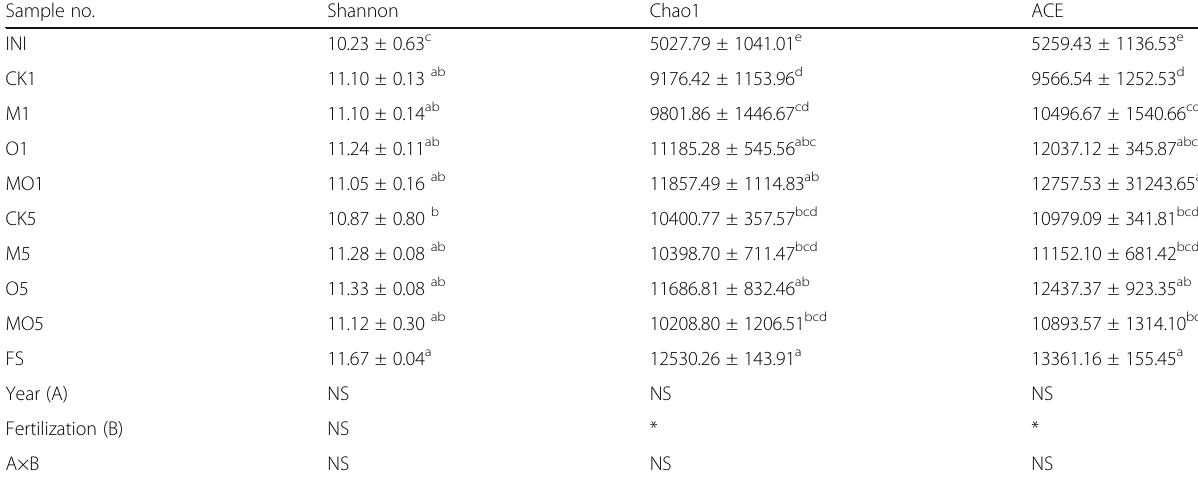
Table 2 Richness and diversity indices for all samples Sample no.